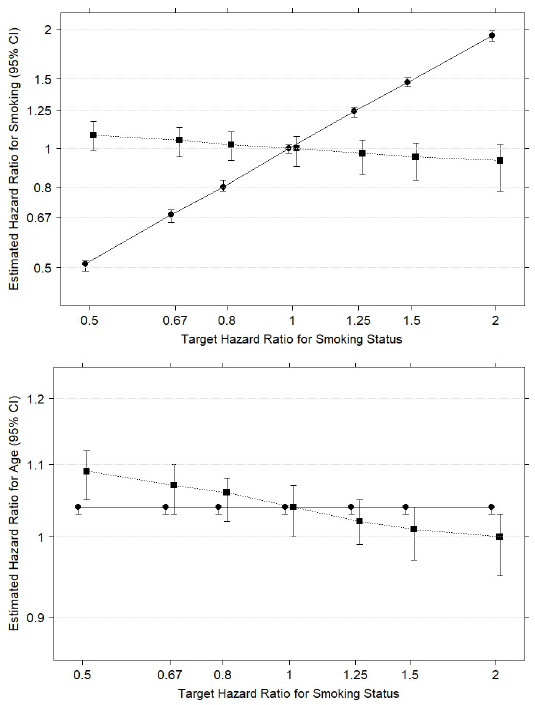
Fig 2. Results from 100 simulated data sets containing age confounding. The first chart shows estimated HRs for smoking status and the second shows estimated HRs for 5-year age group. The CIs with circles joined by solid lines are obtained from fitting the designated ‘true’ smoking status and 5-year age group as predictors of survival using standard Cox regression. The CIs with squares joined by dotted lines are obtained from fitting the designated ‘imputed’ smoking status using, adjusted for 5-year age category, using the I2C2 algorithm.